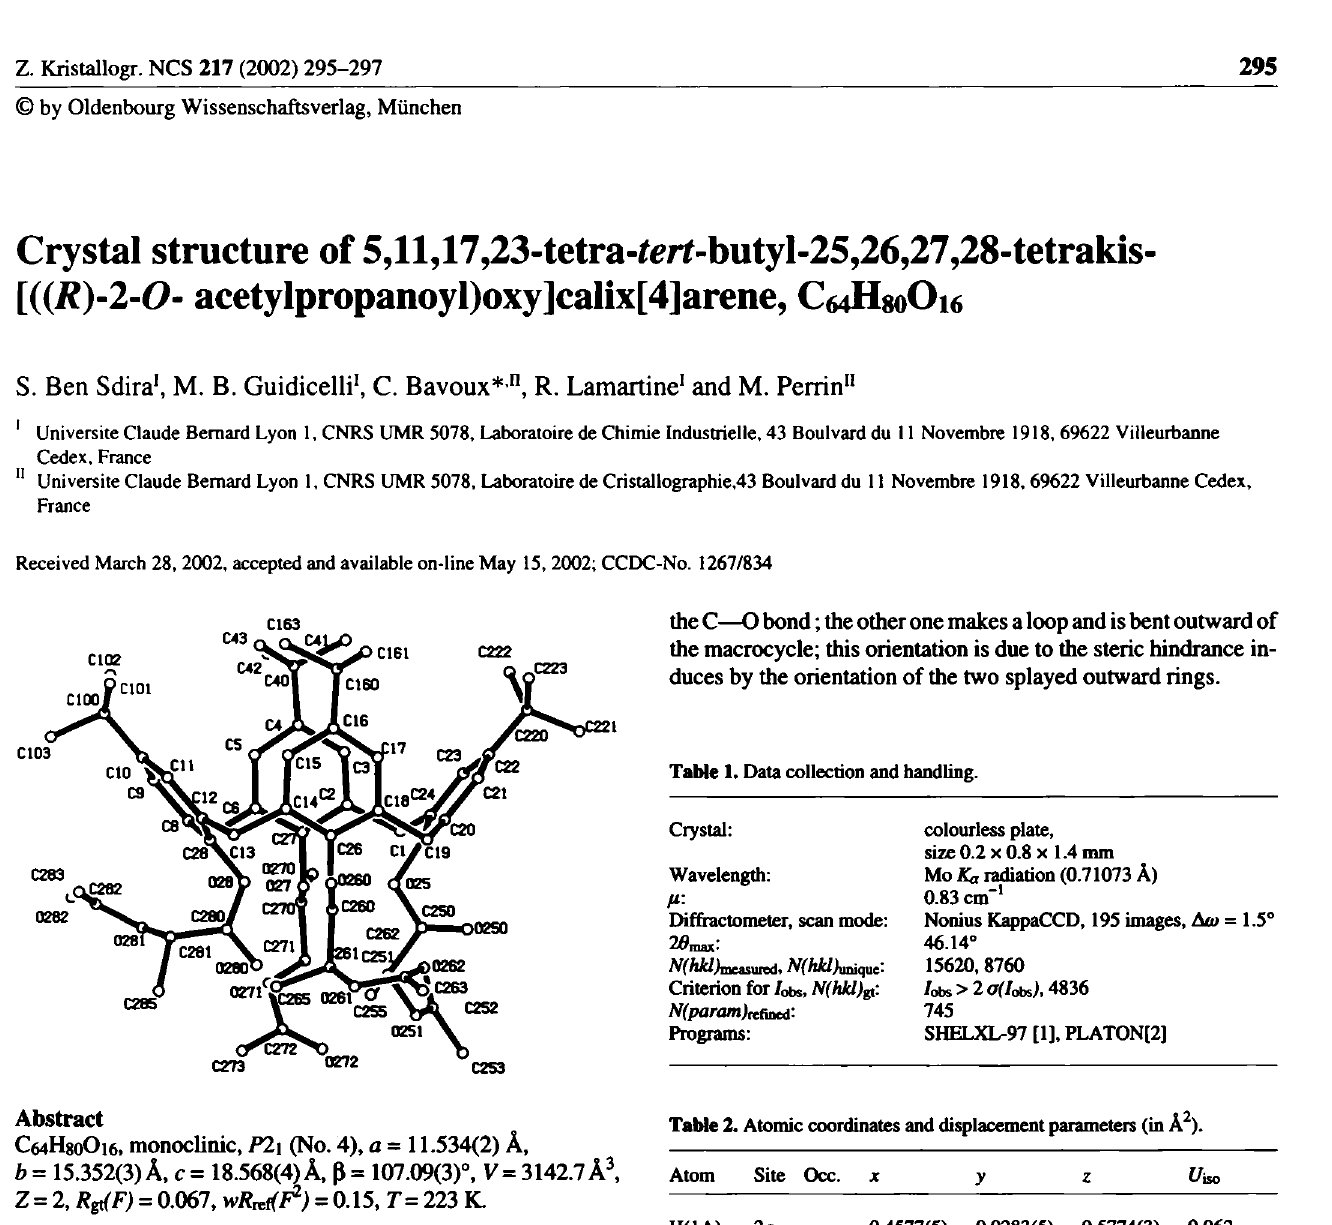
Table 2. Atomic coordinates and displacement parameters (in Â 2